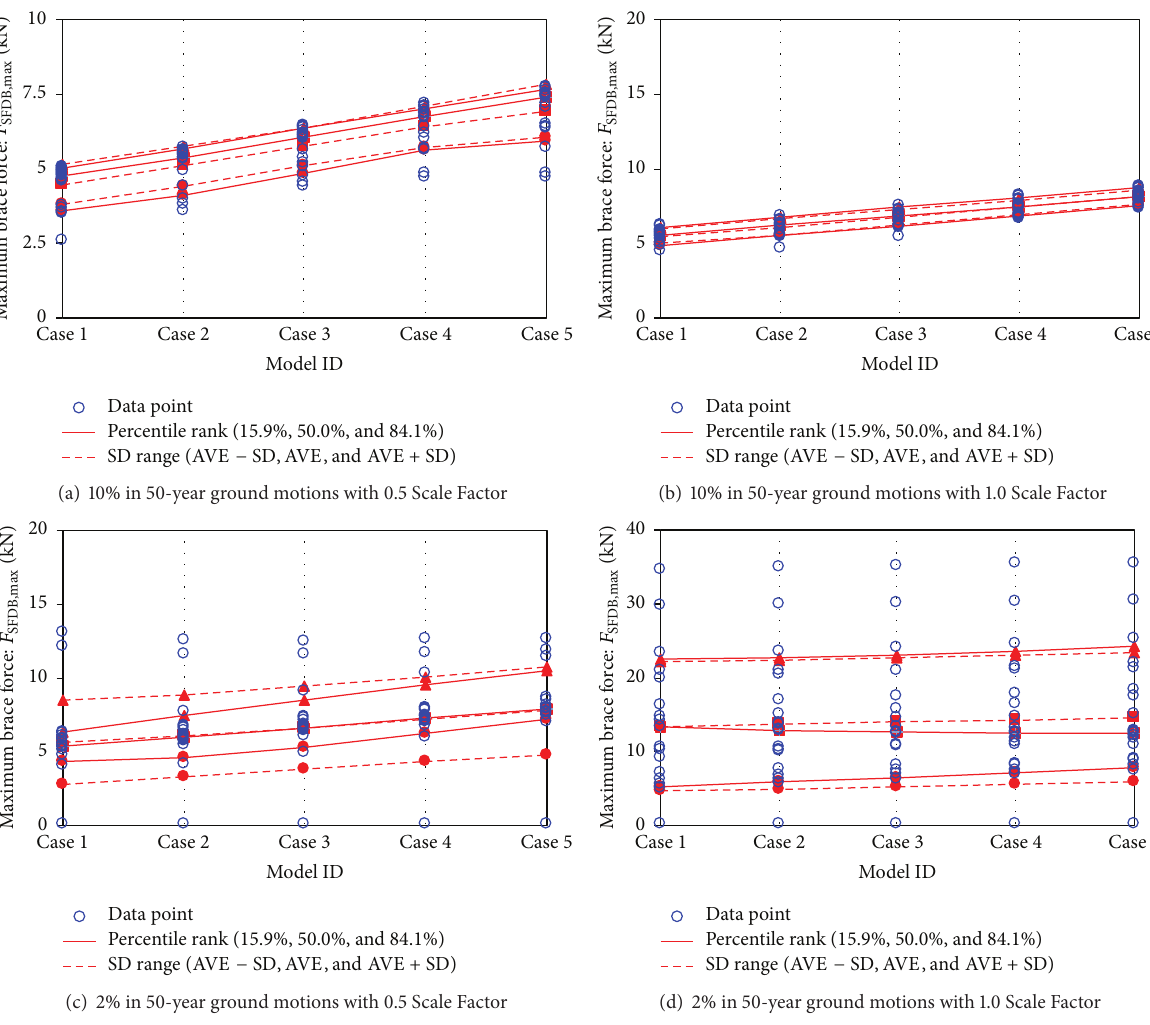
Figure 13: Maximum brace forces ( 𝐹 SFDB , max ) for individual SFDB models under 40 ground motions with different